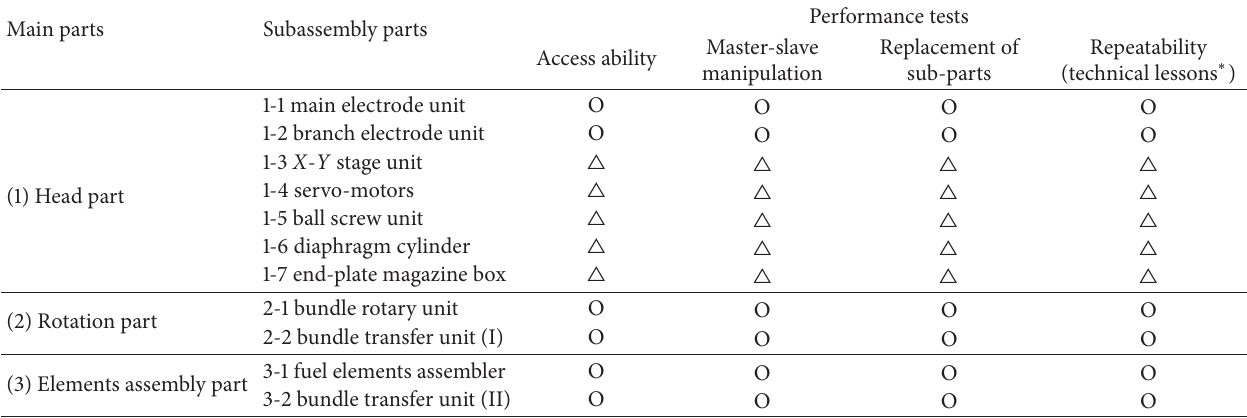
Table 2: Results of a performance test for a remote welding equipment.